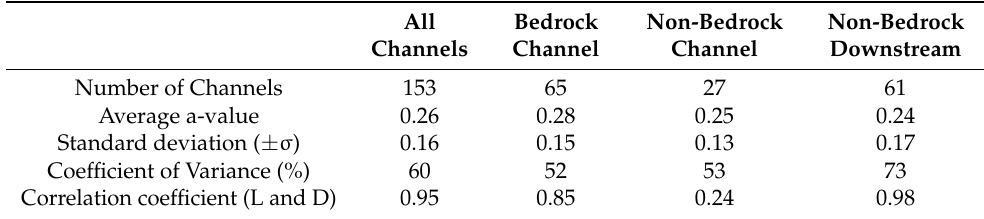
Figure 11. Diagram showing the relationship between the deflection amount (D) and the upstream channel length (L) of bedrock channels with non-bedrock downstream channels. Sixty-one stream channels have been measured. The L and D also represented a good linear relationship with high correlation coefficient of 0.98 (the left one is linear coordinate system, and the right one is double logarithmic coordinate system). Table 2. Statistical analysis of a-value.